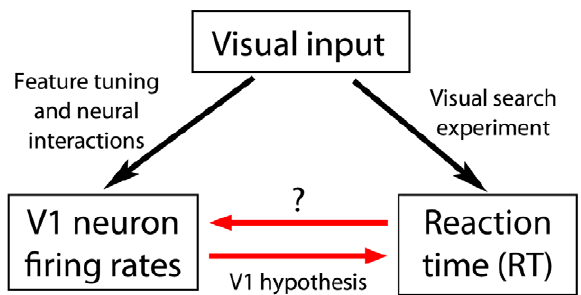
Figure 2. The schematic of our method to probe V1 properties through behavior. Visual inputs drive V1 responses. Meanwhile, the V1 responses determine the behavioral RTs in visual search tasks, according to the hypothesis that the V1 responses represent saliencies of input locations. Therefore, one may probe V1 properties through the relationship between the RTs and V1 responses. In particular, a shorter RT arises from a higher V1 response to the search target relative to those to the background items. Therefore, from the RT data, one can infer relative response levels of the V1 neurons, thereby probing the feature tuning of the V1 neurons and interactions between the